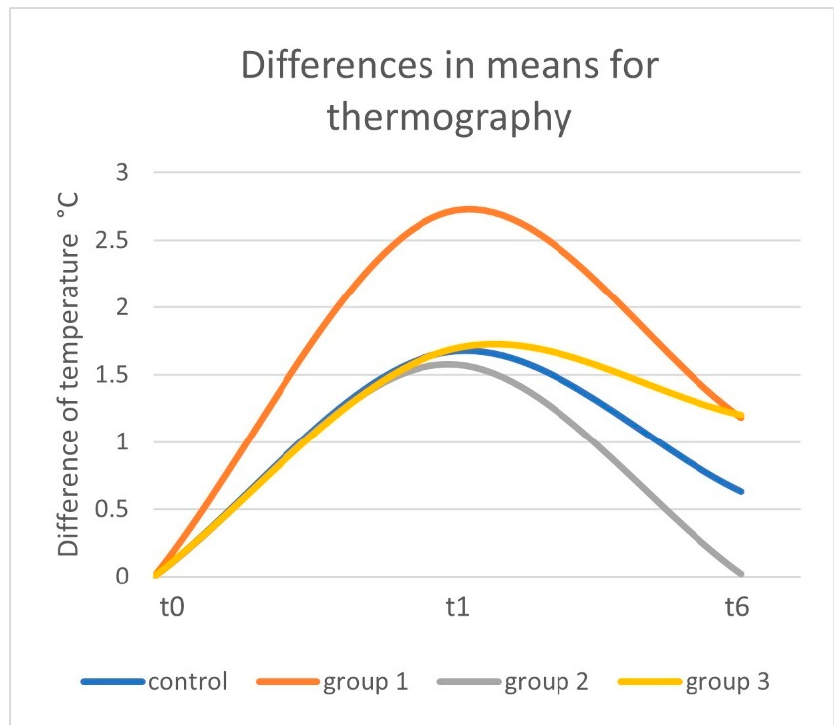
Figure 6. Differences of the means for the temperature in Celsius degrees compared to t0 at t1 and t6, measured by thermography.